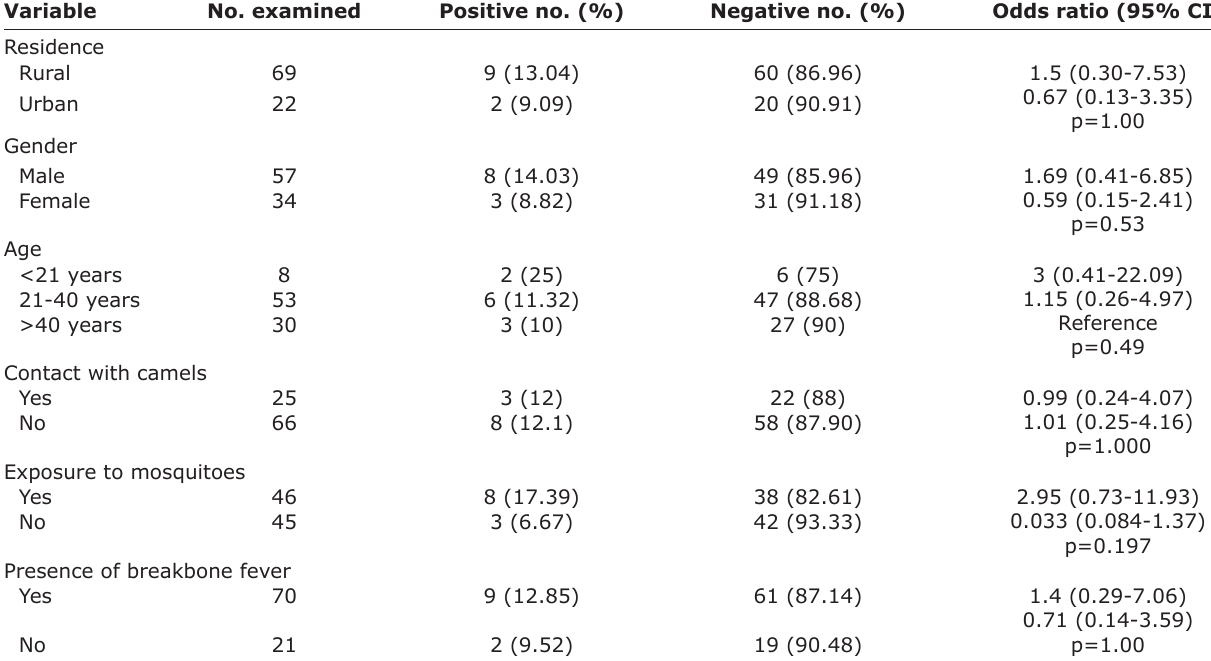
Table-2: Impact of different factors on dengue virus seropositivity in humans.